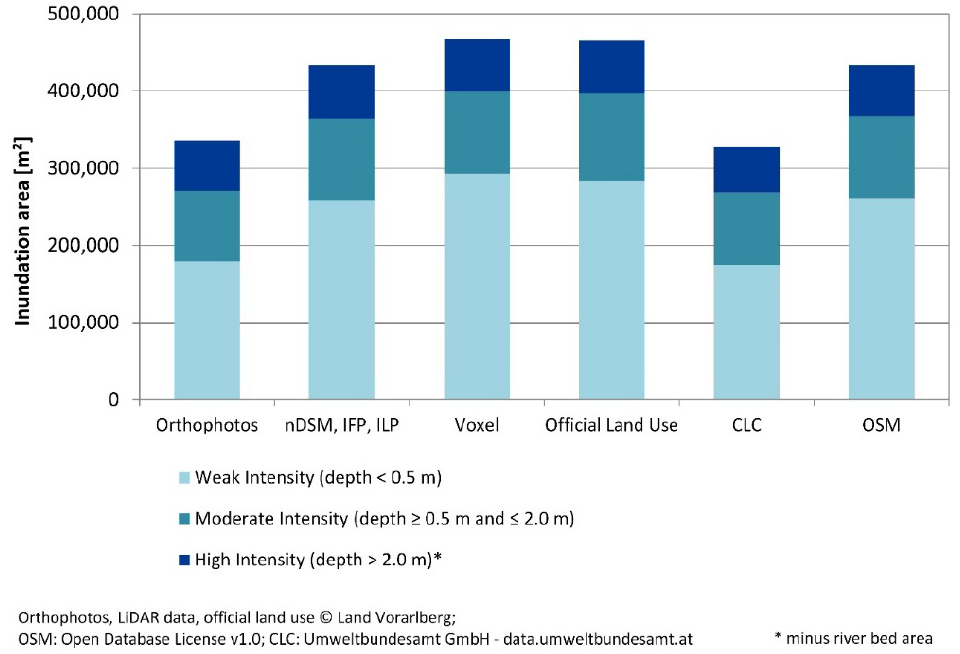
Figure 6. Flood intensity with water depth (m) as impact